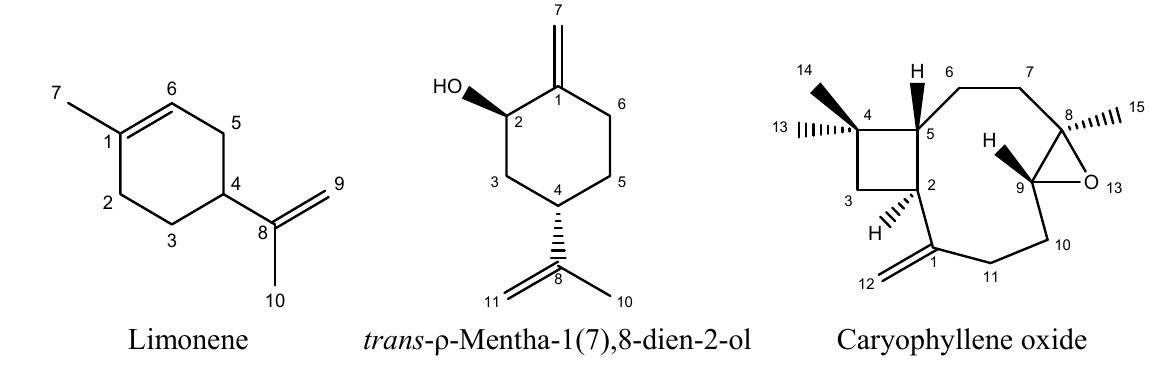
Figure 1. Constituent compounds isolated from the essential oil of Illicium pachyphyllum